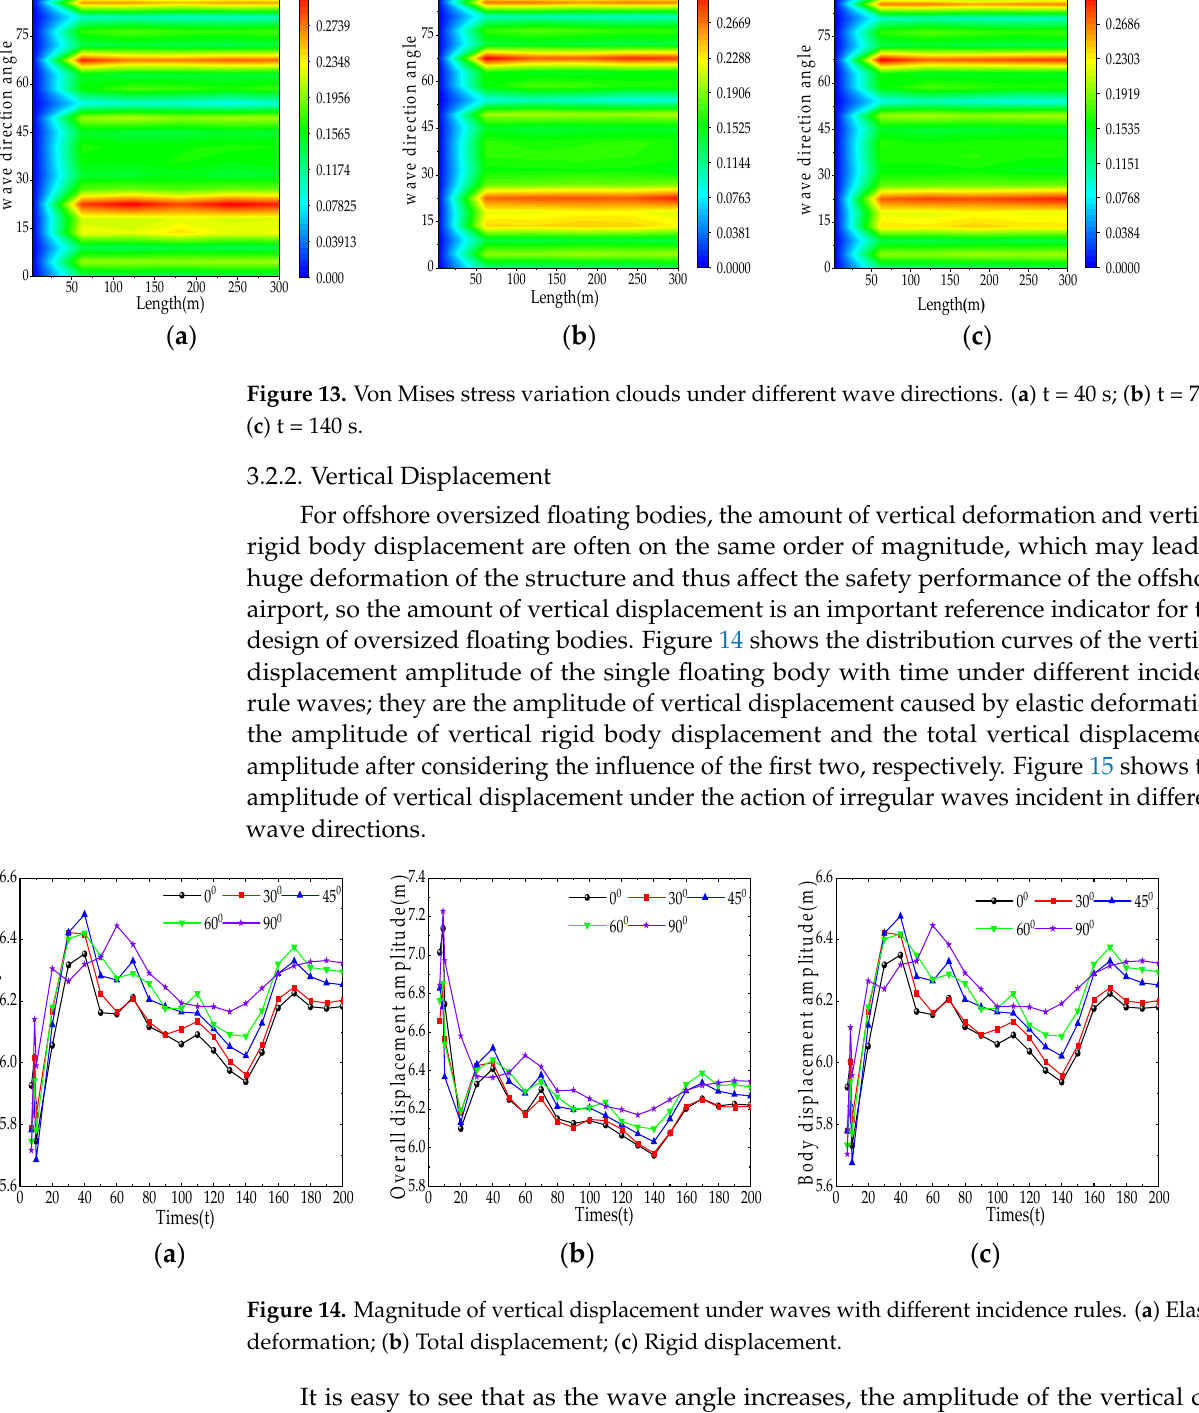
Figure 15. Magnitude of vertical displacement under different incident irregular waves. ( a ) Elastic deformation; ( b ) Total displacement; ( c ) Rigid displacement. It is easy to see that as the wave angle increases, the amplitude of the vertical dis- placement of the floating body gradually increases. For regular waves, the loading will be initially displaced by the impact of wind and waves, and then will reach a relatively stable vibration range under the dragging effect of the mooring, with small undulations, which basically has no impact on the safety performance of the airport. On the contrary, with the changing curve of vertical displacement amplitude under irregular waves, the displace- ment amplitude caused by elastic deformation is small. The rigid body vertical displace- ment plays a dominant role, and when the wave incidence angle increases, the rigid body displacement peak peak increases, which is more obvious in extreme weather conditions, and will seriously affect the normal work of the offshore airport. It is worth noting that the total vertical displacement amplitude of the floating body cannot be considered as a